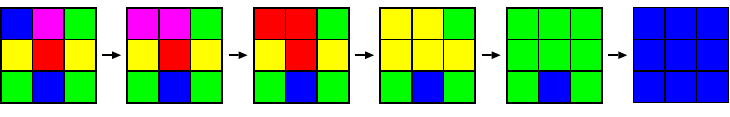
Fig. 1: An optimal sequence of moves to flood a 3 × 3